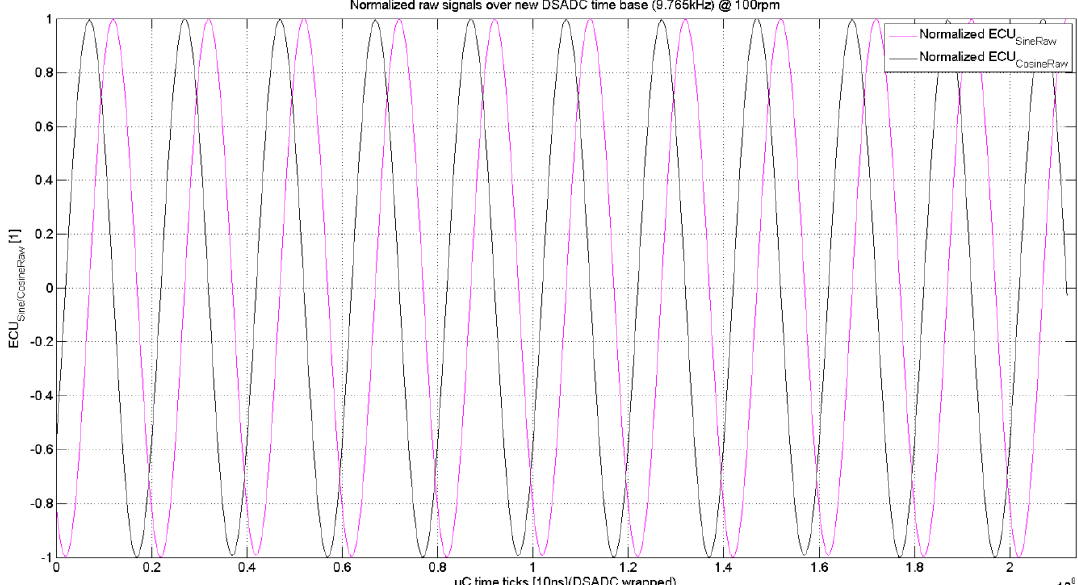
Figure 18. Resulting resolver sensor signal normalization and offset compensation from the offline post processing. The upper plot (magenta curve) shows the normalized and symmetrical sine feedback signal, while the lower plot (black curve) shows the normalized and symmetrical cosine resolver feedback signal on the introduced continuous DSADC time base in μ C time ticks (10 ns).